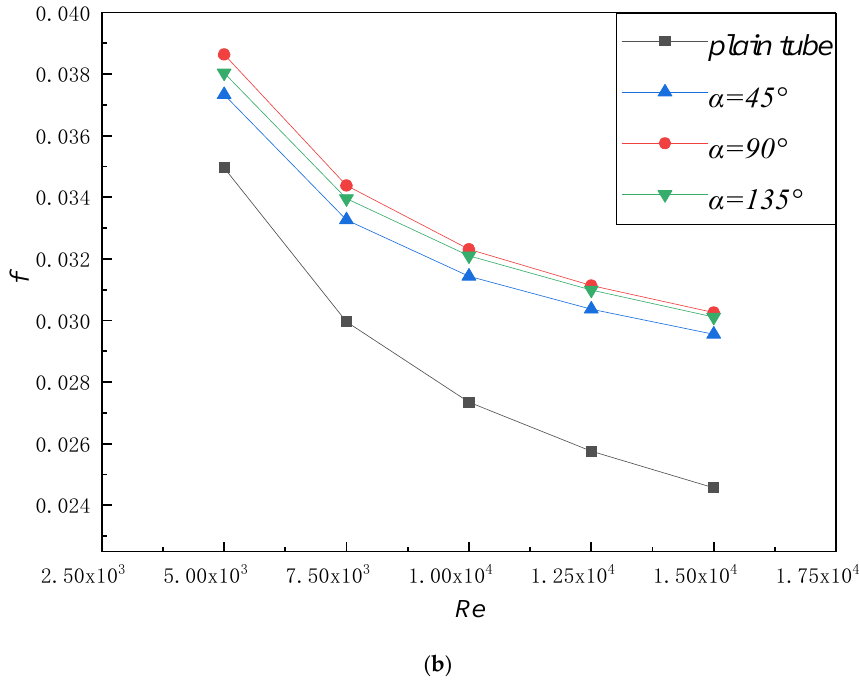
Figure 7. Comparison of heat transfer and flow resistance between plain tube and smooth tube with RWVGs in different α . ( a ) Nu , ( b ) f .